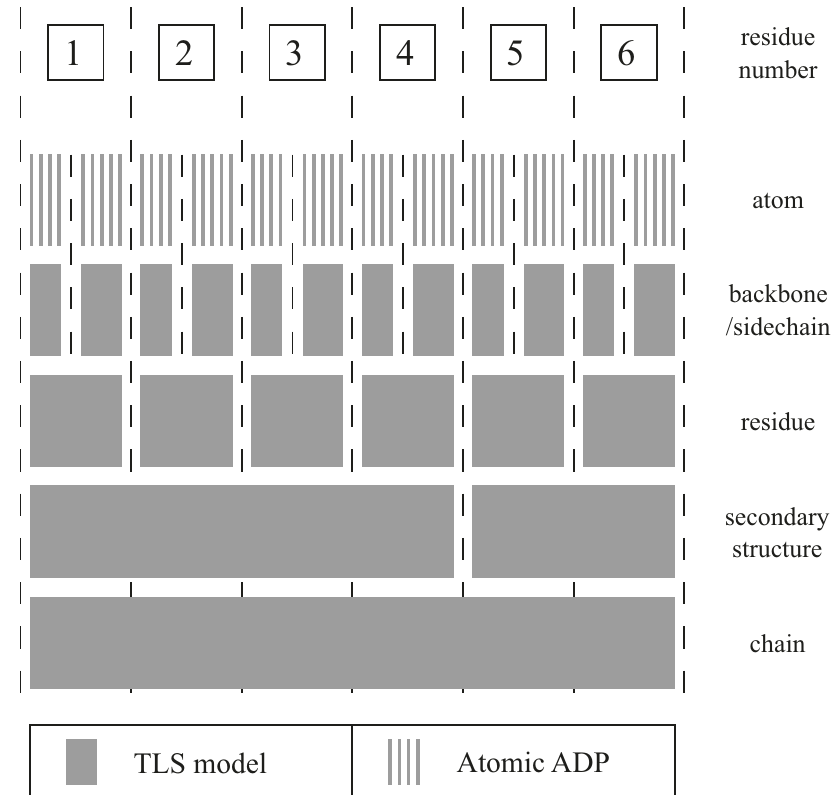
Fig. 2 Hierarchical disorder model partitioning. A possible model partitioning is shown for six residues. The bottom ( fi rst) level contains a TLS group for all atoms, the second level into two TLS groups, and so on. The fi nal (highest) level contains an ADP for each atom. The total ADP for an atom is given by summing the contributions from each